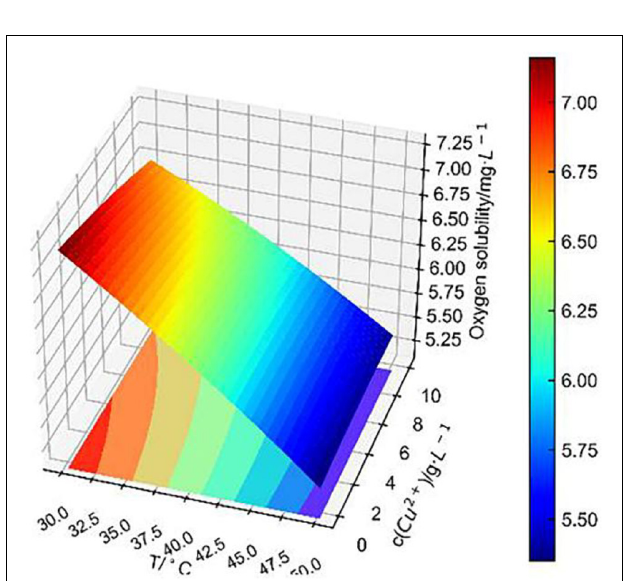
FIGURE 8 | Conjoint effect of temperature and Cu 2 + concentration on dissolved oxygen